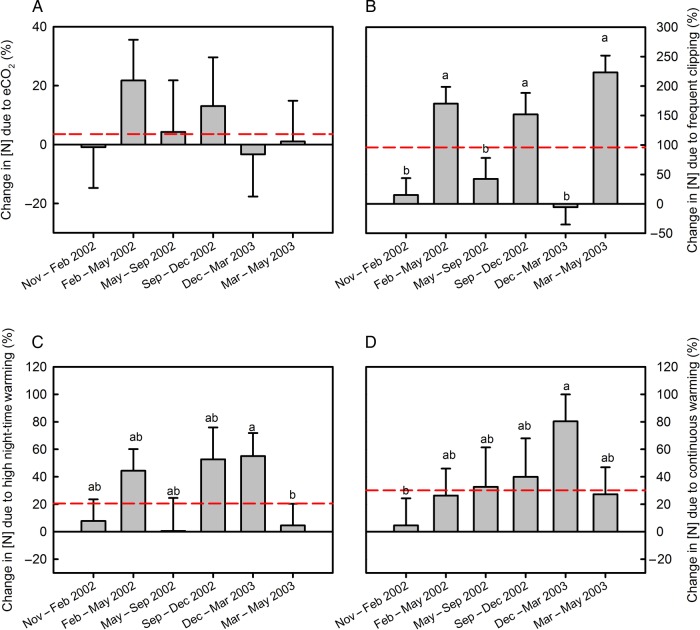
Percent change in litter N concentrations due to (A) increased atmospheric CO2 concentration (756 p.p.m.) compared with ambient atmospheric CO2 concentration (405 p.p.m.), (B) increased clipping frequency, (C) higher night-time warming compared with ambient air temperatures (+2.0/+4.4 °C above ambient, day/night) and (D) continuous warming above ambient (+3.0 °C), as affected by harvest period. The dashed lines indicate the average response to elevated atmospheric CO2 levels (A), increased clipping frequency (B), high night-time warming (C) and continuous warming (D). Data presented are least square means and SEM based on a full model. Different letters indicate statistically significant differences between harvest periods at P < 0.05 using Student's t LSD test.